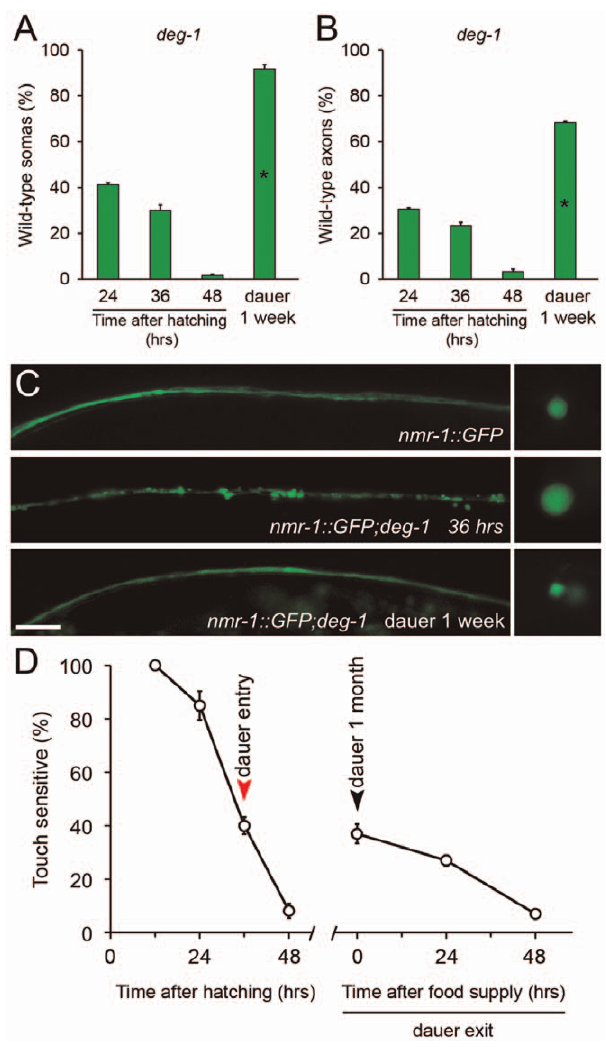
Figure 3. Diapause entry prevents degeneration of the PVC neurons triggered by the deg-1(u38) mutation. deg-1(u38) dauer worms were scored by morphological and functional readouts. Both PVC somas (A) and axons (B) were protected from degeneration when worms were kept in diapause for one week (mean value is shown; error bars indicate SEM; N=3 of 10 worms each per group; *p , 0.01 by Student’s t test compared with 24 hours after hatching). (C) Morphol- ogy of the PVC neuron observed by expression of nmr-1::gfp on wild type (top), deg-1(u38) mutants at 36 hours (middle) and deg-1(u38) dauers (bottom). Scale bar, 10 m m. (D) Posterior touch responses of deg- 1(u38) mutants after hatching, kept as dauers for one month and during dauer exit by food reposition. Only worms that responded to the anterior touch were included (mean values are shown, error bars indicate SEM, N=3 of 33 worms each per